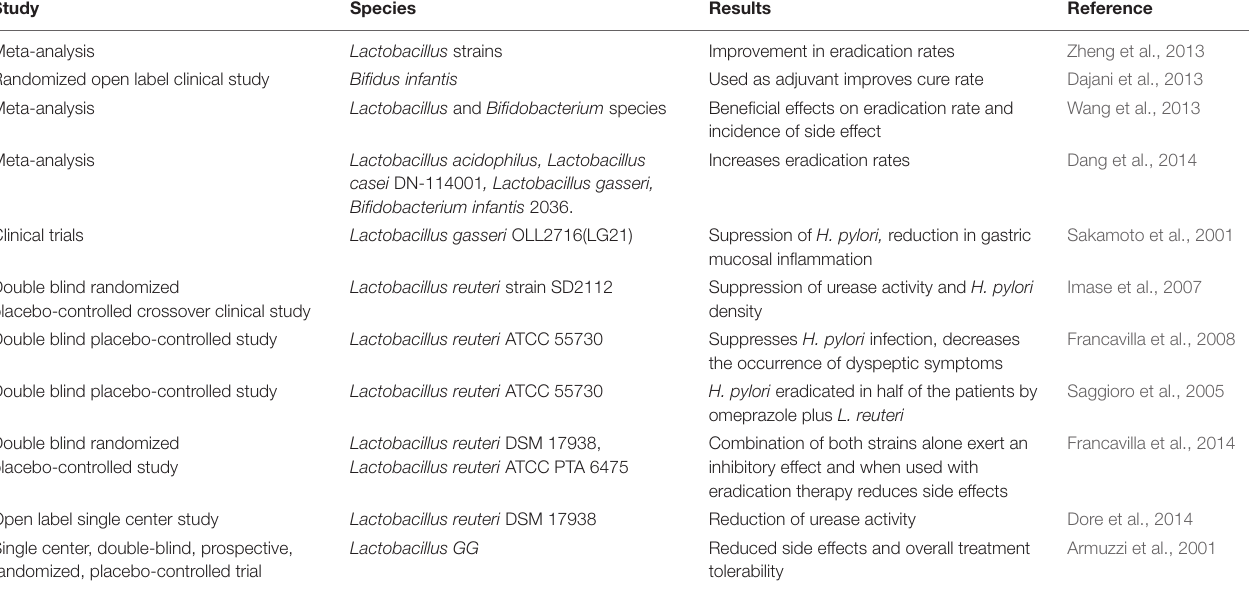
TABLE 1 | Some of the anti- Helicobacter pylori clinical trials and meta-analyses that used